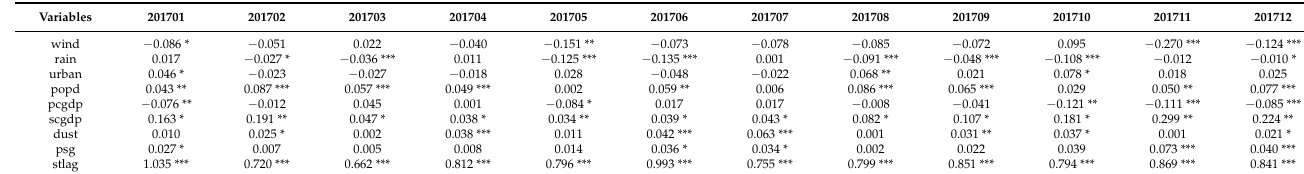
Table 4. Parameter estimates for OLSL.